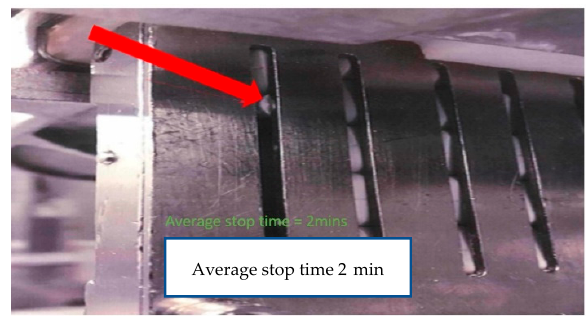
Figure 10. Tablet feed chute blockage (lateral view).